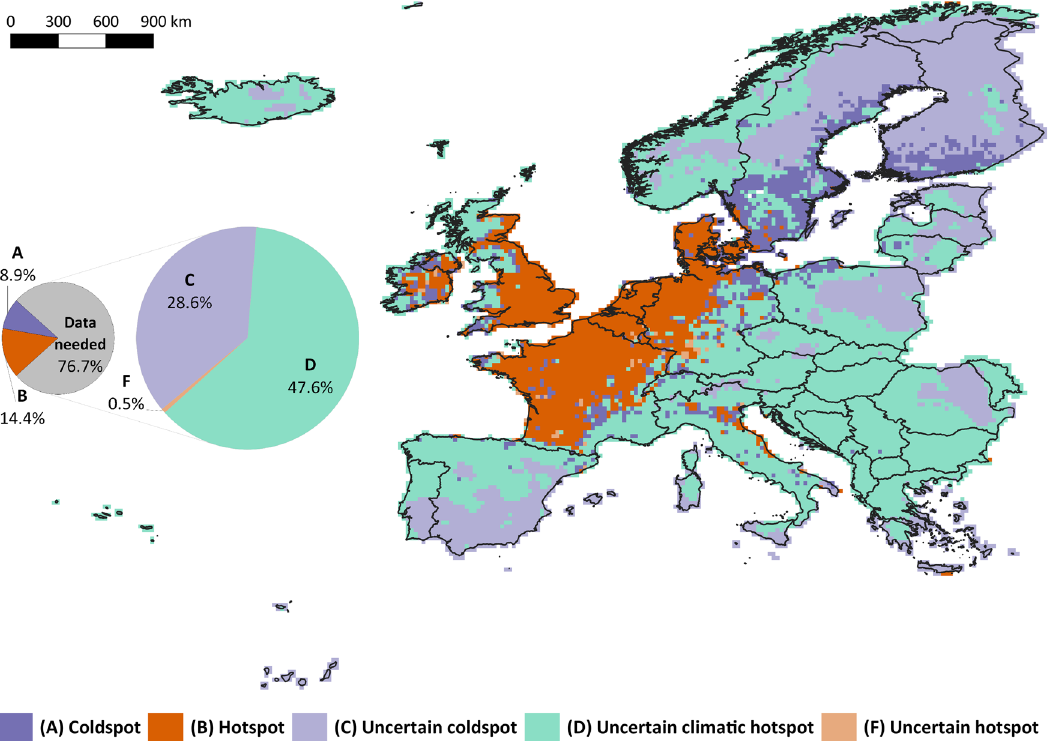
Figure 2. Priority management areas obtained from the application of the classification criteria described in Fig. 1, based on Supplementary Figs. S2.2.1, S2.2.2 and S3.3.1. The pie-chart to the left represents the proportion of grid-cells that belong to each class after aggregating all the categories under the ‘uncertain areas’ group, i.e. zones C to F (grey area). The pie-chart to the right represents the percentage of grid-cells within each category within ‘uncertain areas’. No grid-cell was classified as E (uncertain environmental hotspot). This figure was generated with QGIS v.3.2.3 66 (www.qgis.org).